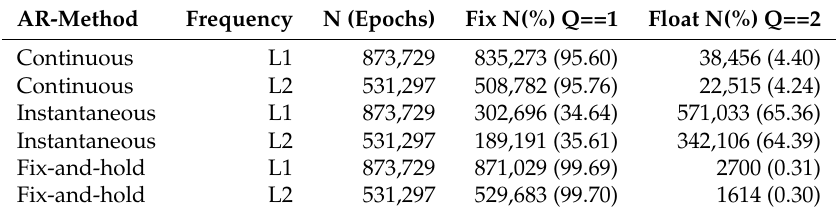
Table A1. Fix and float satellite residuals summary of the LEIAR25.R3 LEIT antenna on DOY 79. For the fix-and-hold ambiguity solution, ’hold’ epochs are considered as fix